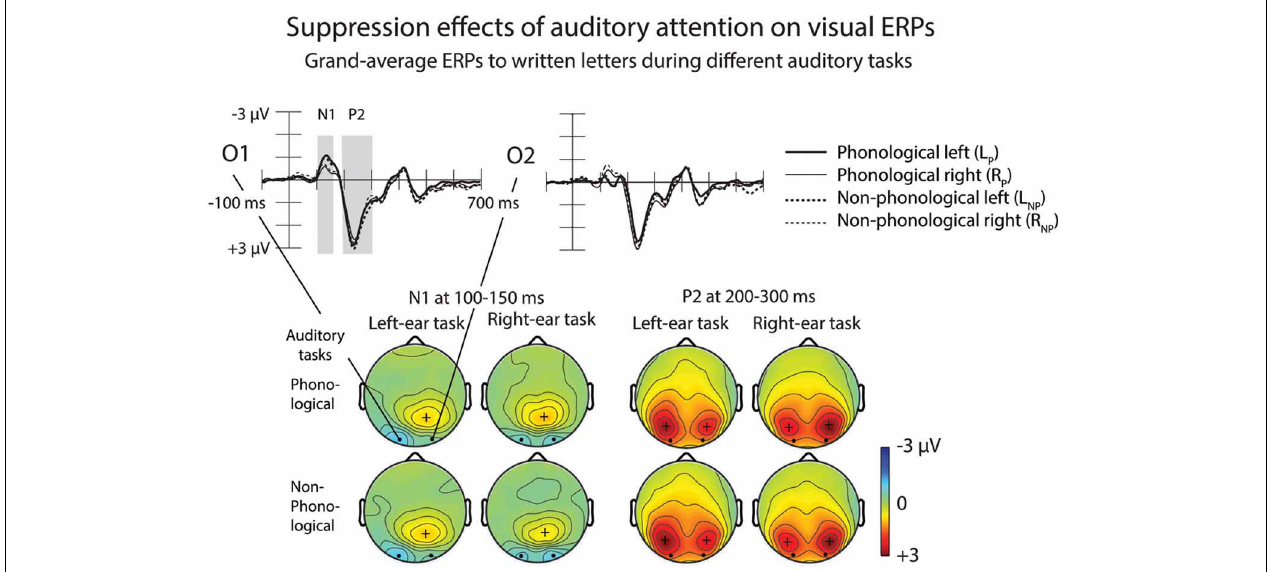
FIGURE 7 | Suppression effects of auditory attention on visual ERPs. Grand-average ERPs to written letters during different auditory tasks at the O1 and O2 electrodes are shown on the upper panel. Scalp maps on the lower panel show N1 and P2 responses at 100–150 and